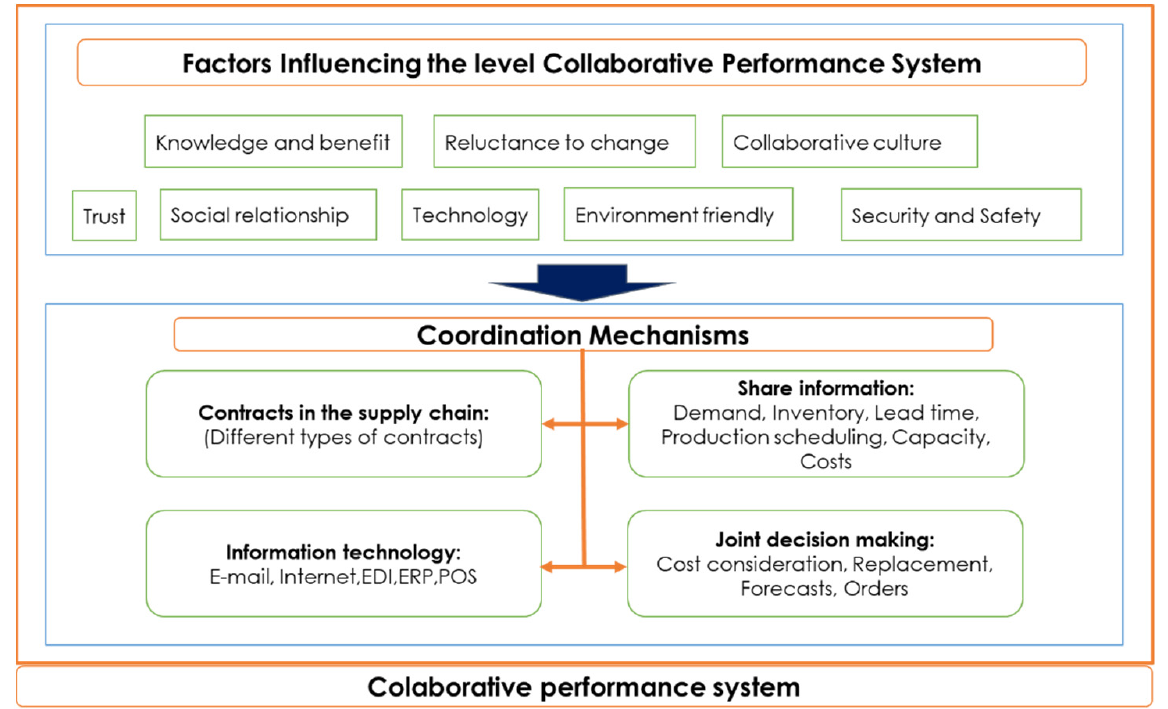
Figure 1. Framework for classifying coordination mechanisms and collaborative performance system, adapted from [28,32,34].